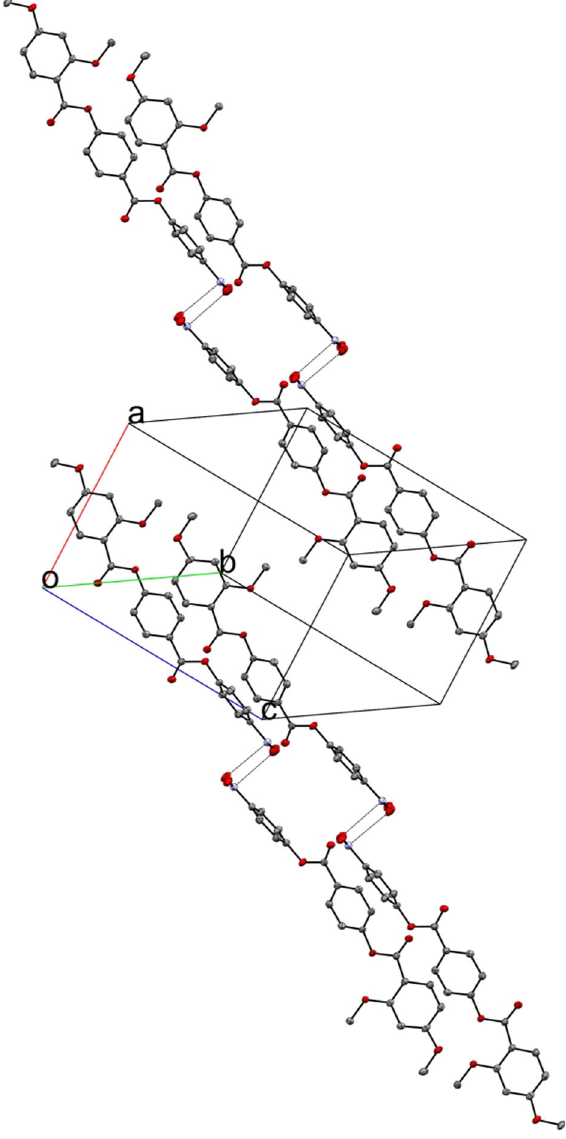
FIG. 9. (a) 2D SAXS pattern of RM734 in the N 130 °C; the 2D scattering data are radially integrated in the regions defined by the two wedges in (a) to give d-spacings of the (001), (002), and (003) peaks [bottom wedge, see Fig. 9(c)] and the (100) peak (left wedge). (b) Expansion of the small-angle region of (a) showing three weak scattering events. (c) Fitting of raw SAXS data at 80 °C to extract d-spacings of the (001), (002), and (003) peaks. (d) Plot of the d-spacings of small- [(001), (002), (003)] and wide-angle [(100)] peaks as a function of temperature. Solid lines correspond to phase transitions.